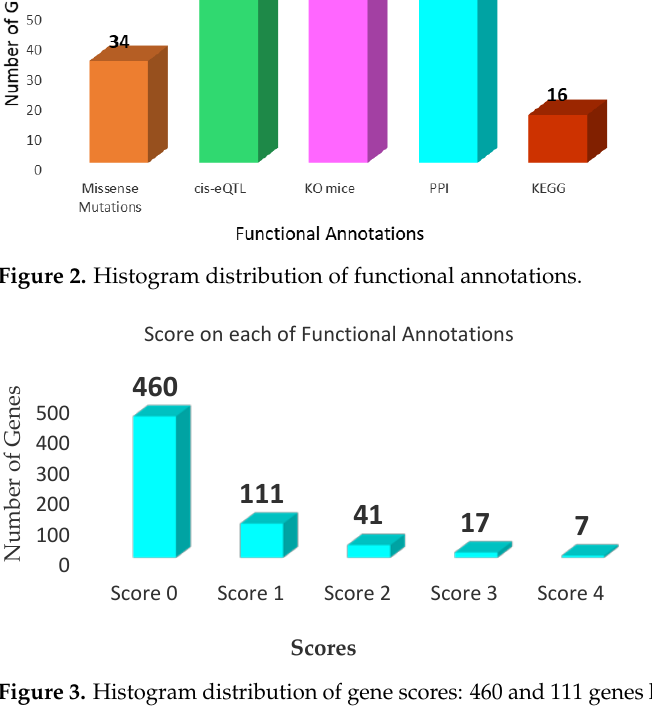
Figure 2. Histogram distribution of functional annotations.